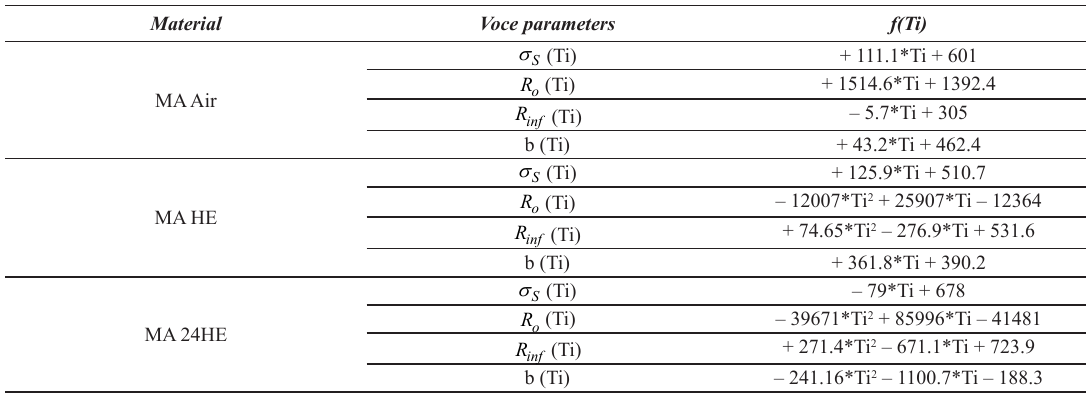
Table 6. Generalized Voce parameters as a function of the titanium contend present on ST maraging steels in air, HE and 24HE environment conditions.